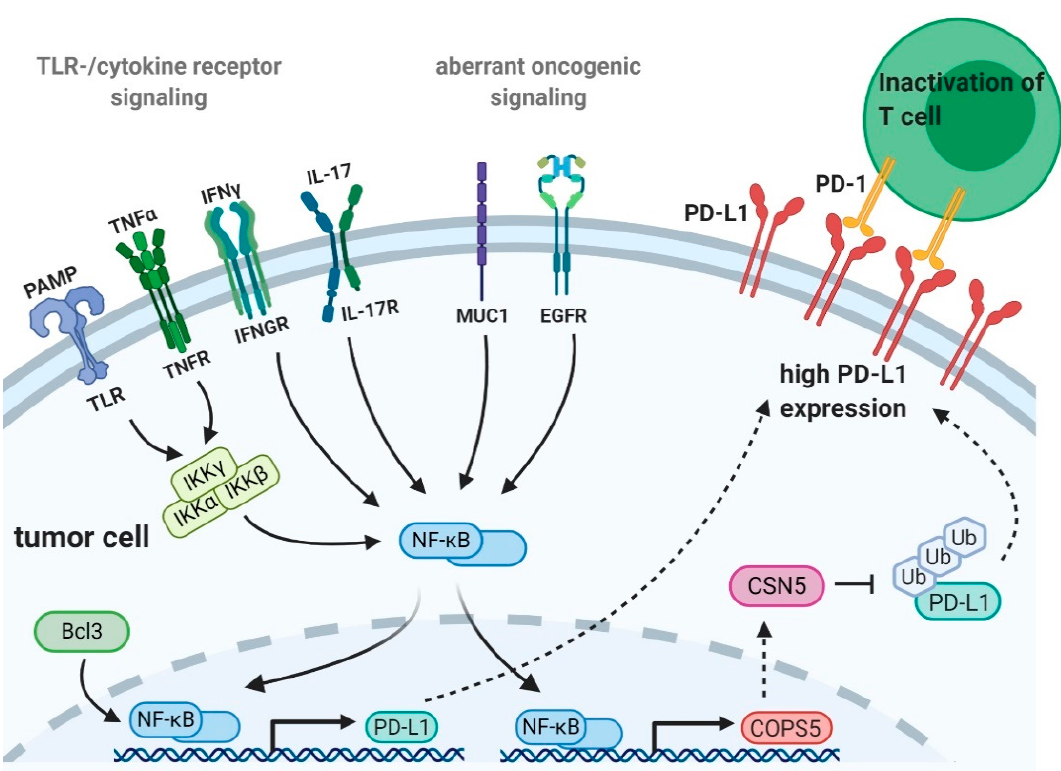
Figure 1. Transcriptional and posttranslational regulation of programmed-death ligand 1 (PD-L1) by Nuclear factor- κ B (NF- κ B). Nuclear factor κ B (NF- κ B) is involved in transcriptional and posttranslational regulation of programmed-death ligand 1 (PD-L1) in immune and tumor cells. Toll-like receptor (TLR)- and cytokine receptor-signaling induce NF- κ B activation and trigger its nuclear translocation enabling its binding to the PD-L1 promoter [34,55,67]. TLR- and tumor necrosis factor receptor (TNFR)-signaling activate the canonical NF- κ B pathway by signaling via the I κ B kinase (IKK) complex [7]. The exact mechanisms by which interferon γ (IFN γ ) and interleukin-17 (IL-17) activate NF- κ B are not completely understood. Aberrant expression of the oncogenes B cell lymphoma 3 (Bcl3) and mucin1 (MUC1) or epidermal growth factor receptor (EGFR) mutations are also described to induce NF- κ B-mediated PD-L1 transcription [40,51,103]. NF- κ B post-translationally regulates PD-L1 expression by inducing transcription of the COP9 signalosome complex subunit 5 (COPS5) gene encoding the fifth element of the COP9 signalosome (CSN5), which deubiquitinates and therefore stabilizes PD-L1 [38]. All of these mechanisms lead to high PD-L1 expression on tumor cells thereby contributing to tumor immune escape. Arrows indicate paths to NF- κ B activation, dotted arrows indicate protein translation and translocation, T-bars indicate inhibition. Figure 1 was created with BioRender.com.